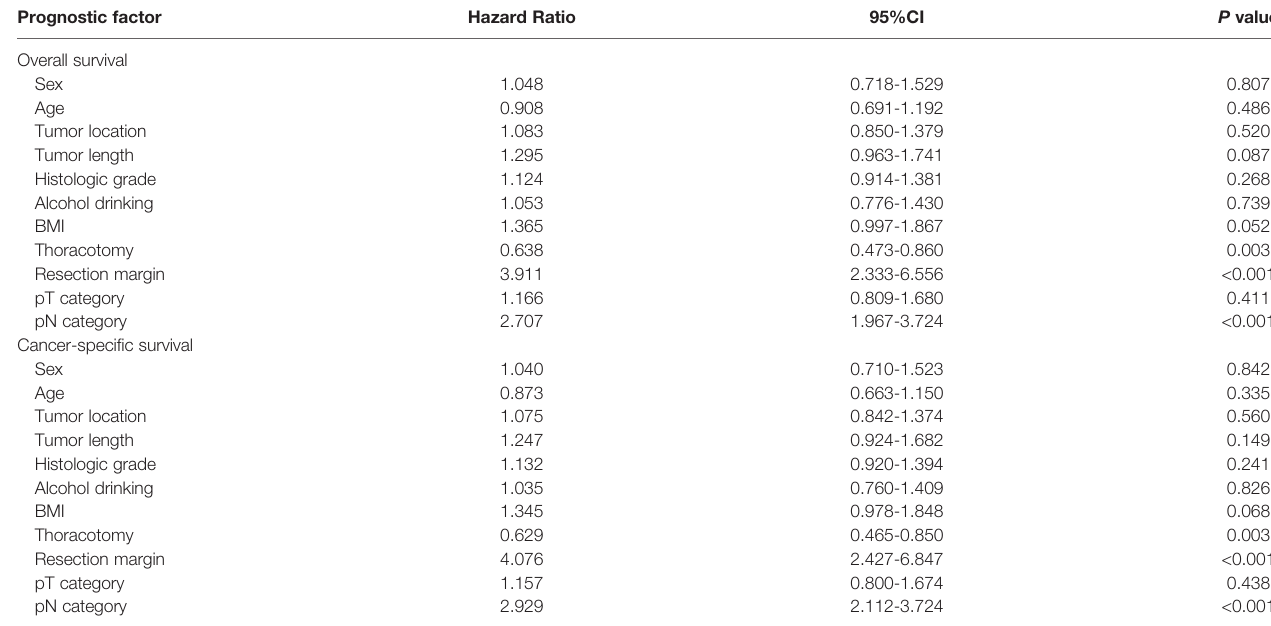
TABLE 3 | Multivariate analysis in regard to overall survival and cancer-speci fi c survival of the 620 patients with esophageal squamous cell carcinoma. Prognostic factor Hazard Ratio Overall survival